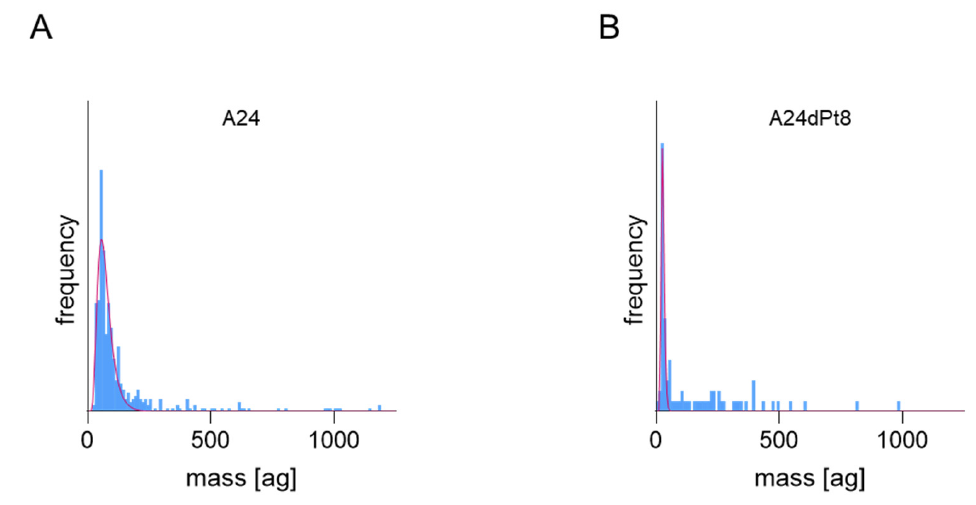
Figure 6. Frequency plots of isolated nuclei from ( A ) A24 cells and ( B ) A24dPt8 cells incubated with 30 µ M cisPt for 16 h. The red curve shows the lognormal fit of the frequency. Average concentration of cisPt in nuclei of sensitive and resistant cells were deter- mined, using measured nuclear volumes. The average cisPt concentration detected by SC-ICP-MS for 8 h in A24 cells was 0.6 ± 0.08 µ M cisPt per nucleus, and 1.02 ± 0.27 µ M cisPt per nucleus after 16 h of incubation. In contrast, determination of nuclear cisPt concen- tration in resistant A24dPt8 cells revealed an average concentration of 0.23 ± 0.06 µ M cisPt per nucleus at 8 h. At 16 h, an average of 0.59 ± 0.17 µ M cisPt per nucleus was detected. CisPt concentrations measured in nuclei or cells within the same cell line are significantly higher in nuclei than in cells. From SC-ICP-MS measurements, an approximate two-fold higher concentration of cisPt was found in nuclei compared to A24 cells at 8 and 16 h, respectively (Figure 7).